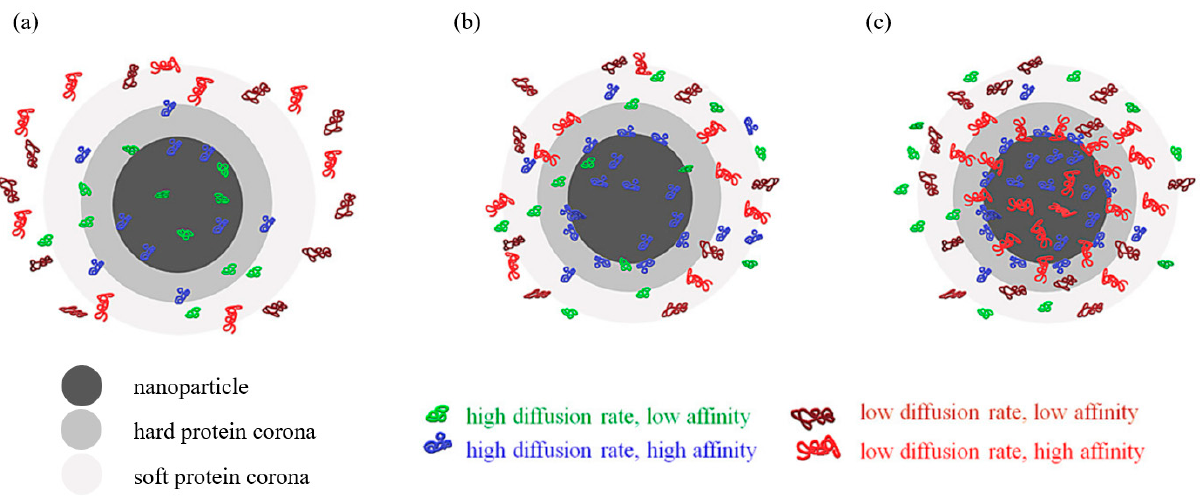
Figure 7. ( a ) Initiation of formation of protein corona (PC) (seconds after the NP reaches the biological fluid); ( b ) beginning of exchange from the PC of proteins with low affinity with proteins that have higher affinity (seconds to minutes); ( c ) stabilized PC, with proteins with high affinity occupying the first layer of PC (hard PC) and the majority of the second layer (soft PC) where proteins with low affinity are still present. Adapted from [146], published by MDPI, 2020.